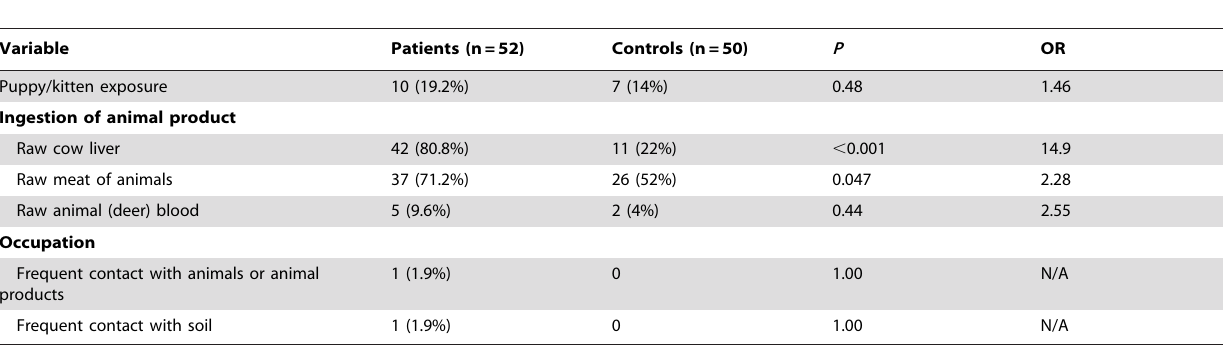
Table 5. Probable sources of infection in adult patients with ocular